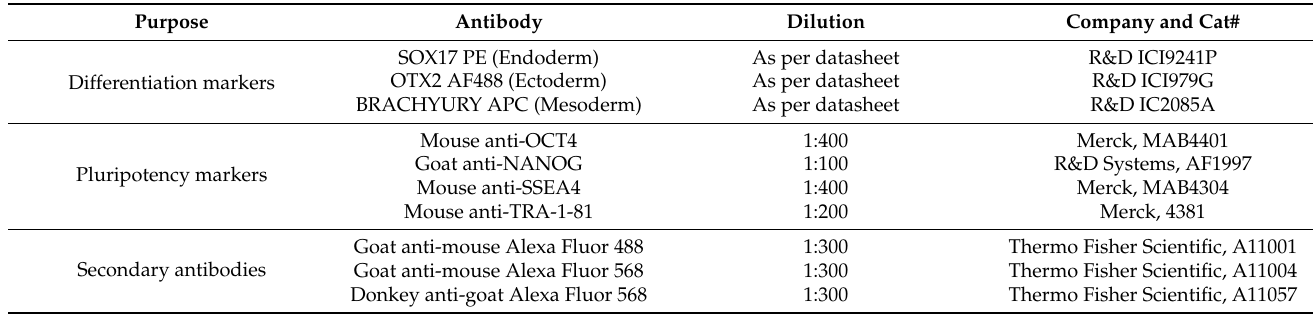
Table 3. Antibodies used to characterize the induced pluripotent cell line Mad6. Antibodies pro- duced by R&D Systems, Minneapolis, MN, USA, Merck KGaA, Darmstadt, Germany and Thermo Fisher